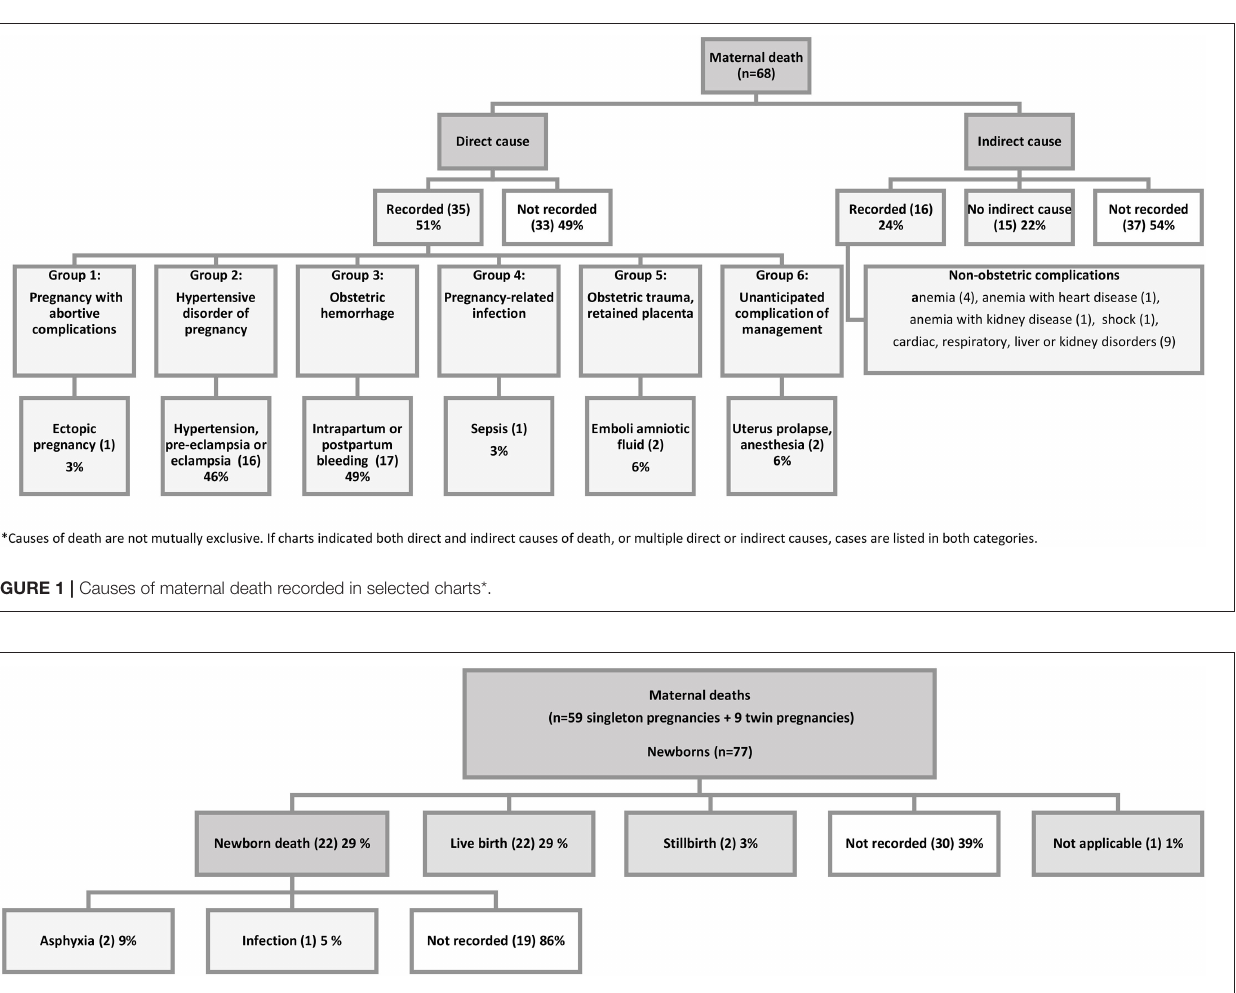
FIGURE 2 | Newborn outcome recorded in selected maternal mortality